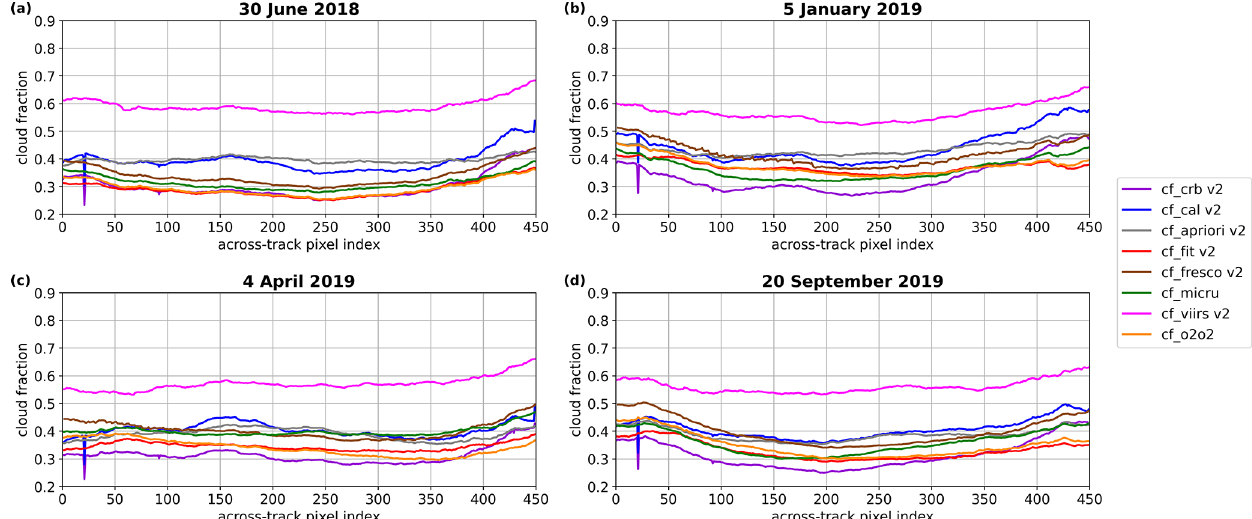
Figure 17. As Fig. 16 but data filtering (quality, snow, and ice flagging) is not applied; thus all valid values are included for each product